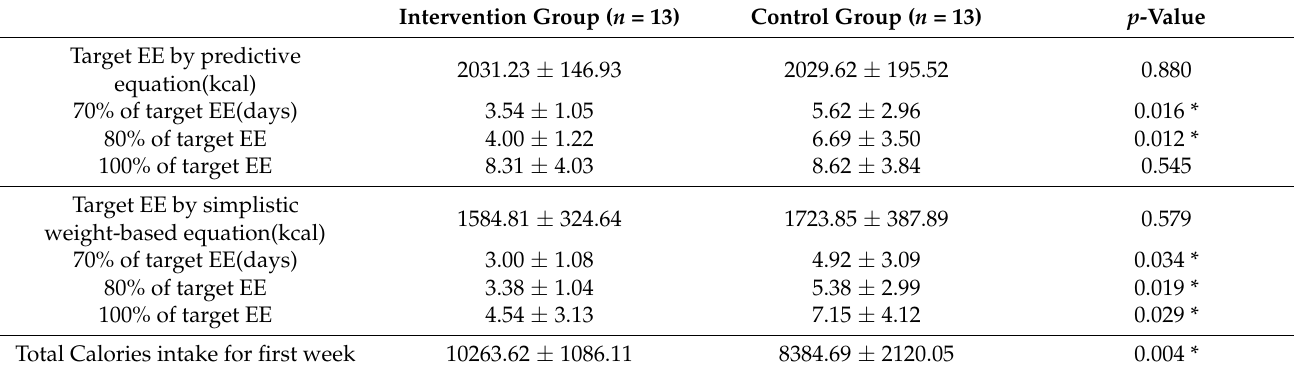
Table 2. Target EE (in kcal) and the duration required to achieve it in both